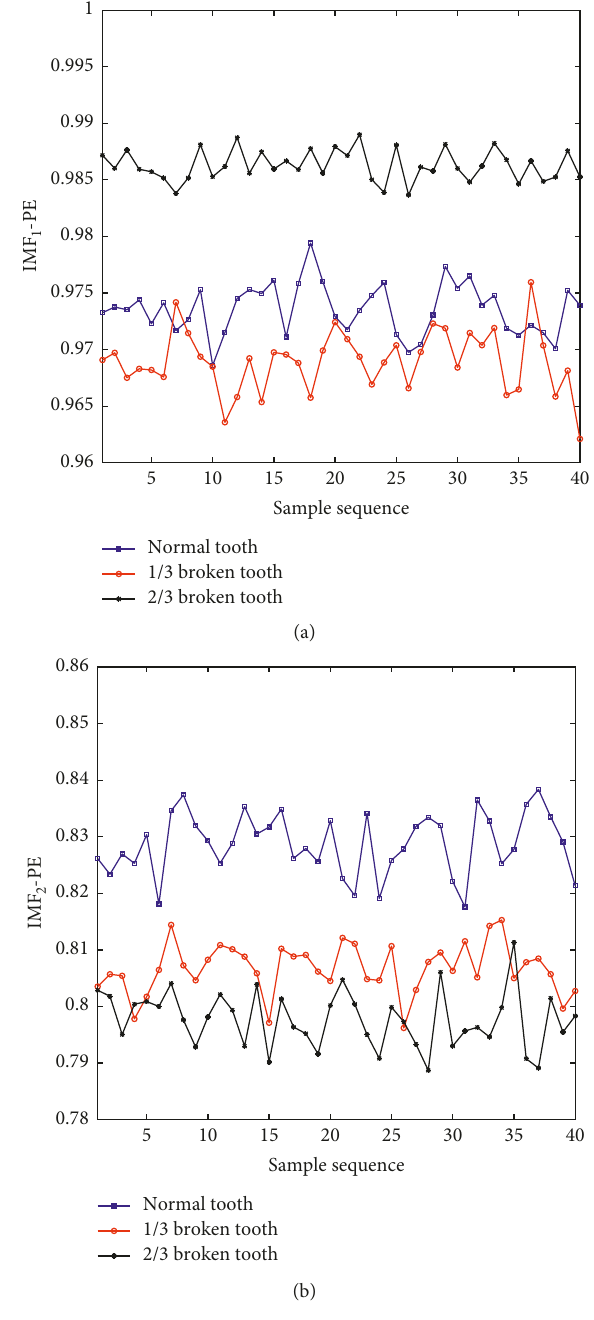
Figure 7: Comparison of CEEMDAN-based permutation entropy of three states. (a) Permutation entropy of IMF 1 . (b) Permutation entropy of IMF 1